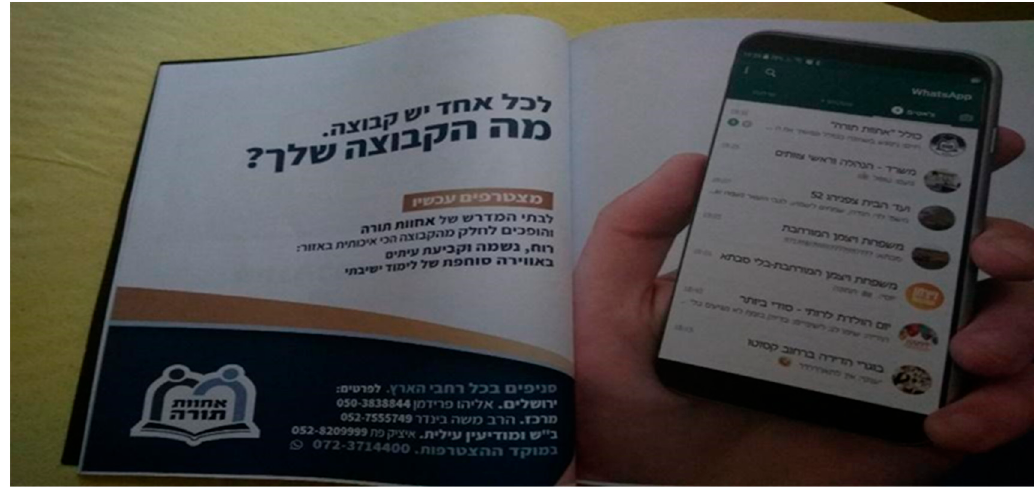
Figure 2. Advertisement for a working Haredi Kollel (2019).